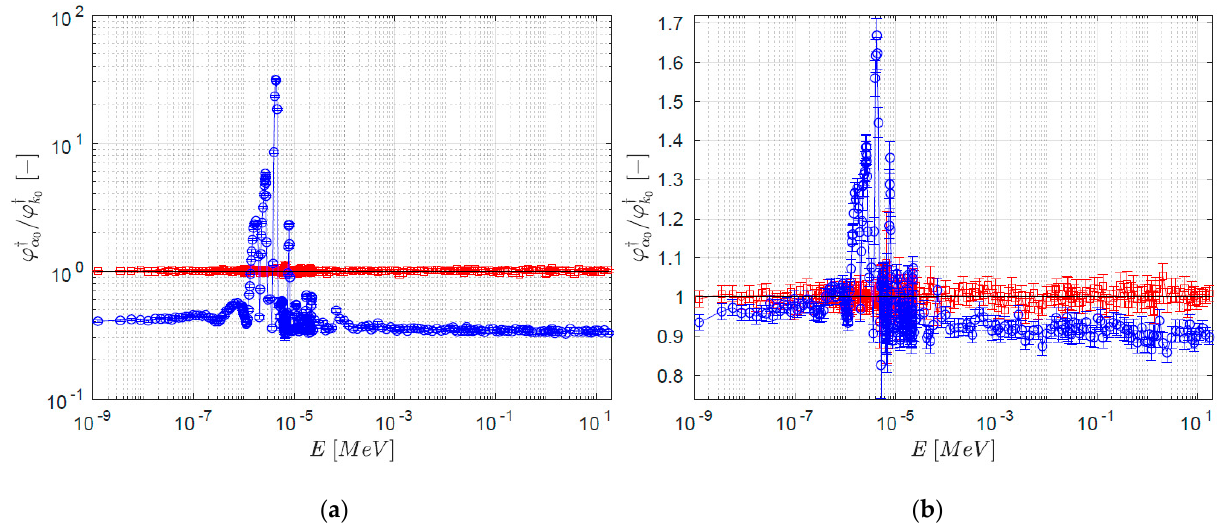
Figure 4. Problem I, ratios ϕ † α / ϕ † of the adjoint fundamental distributions, for sub-critical ( a ) and super-critical ( b ) configuration, with (red squares) and without (blue circles) delayed contributions.